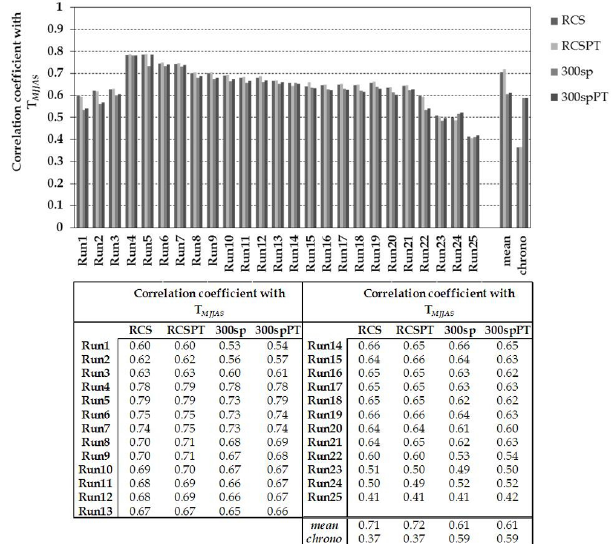
Fig. 5. Pearson’s correlation coefficient of the PC1 of each PCA run (1 to 25) and the regional chronologies “mean” and “chrono” and May-to-September mean temperature ( T MJJAS ) for each standard- ization method (RCS, RCSPT, 300sp,